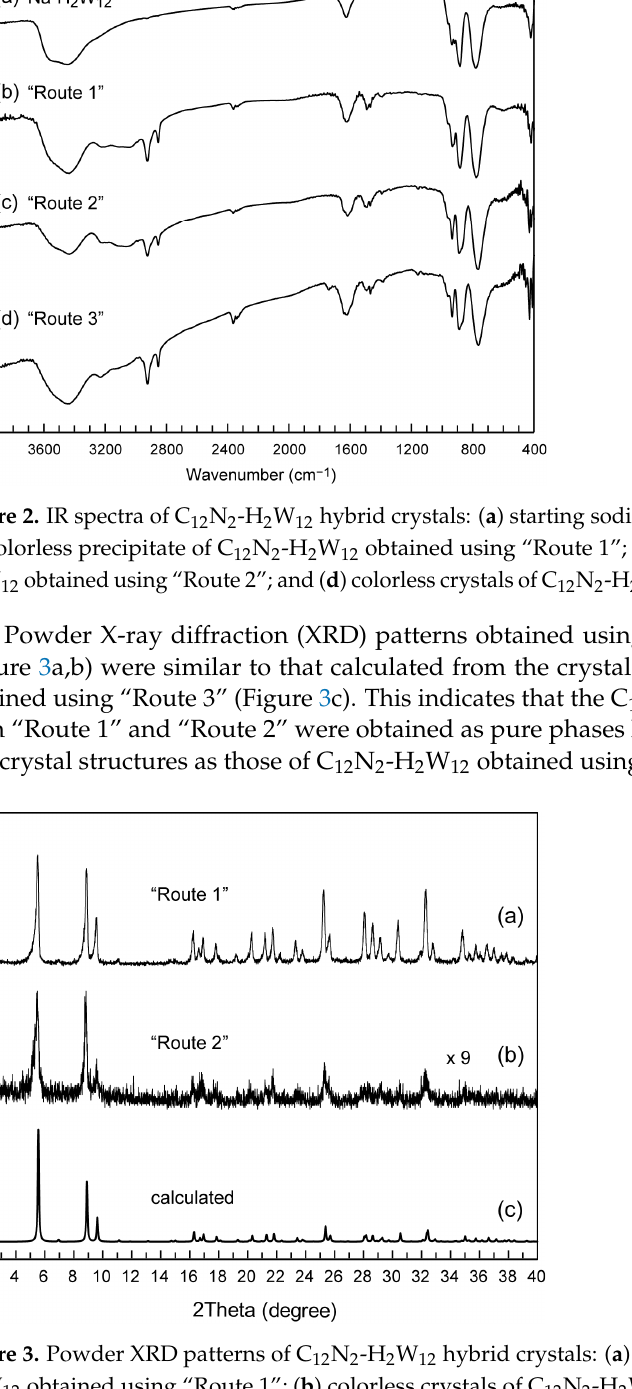
Scheme 1. Schematic representations of synthetic procedures for C 12 N 2 -H 2 W 12 hybrid crystals: ( a )